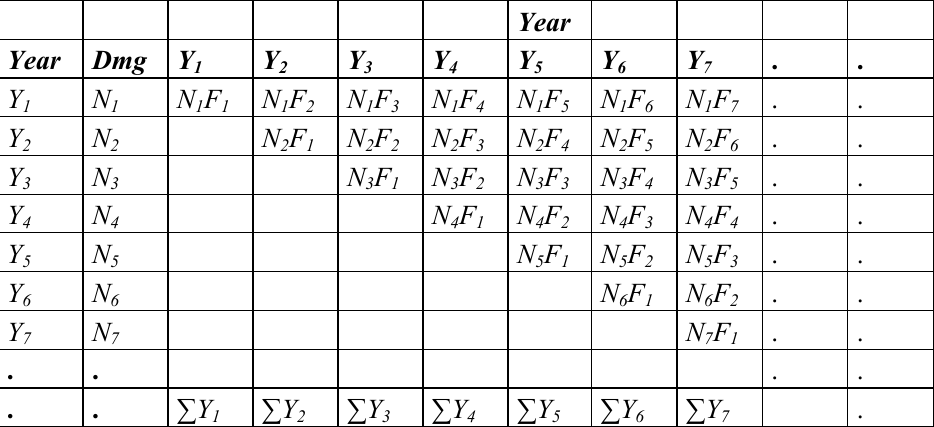
F ) emanating from i j